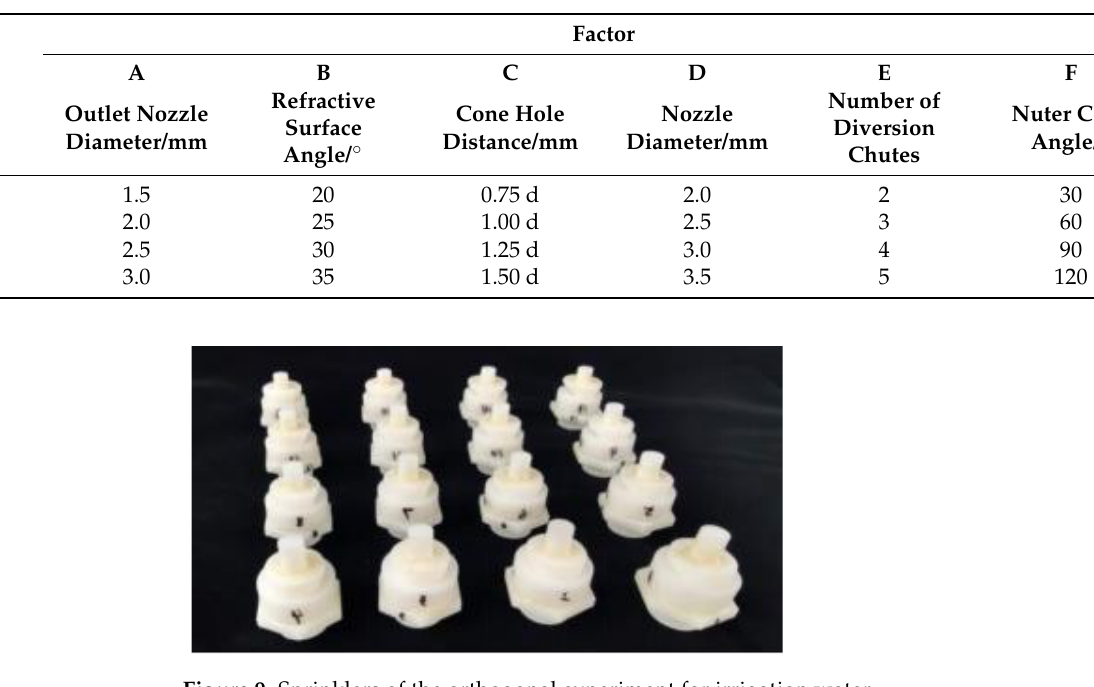
Figure 9. Sprinklers of the orthogonal experiment for irrigation water.